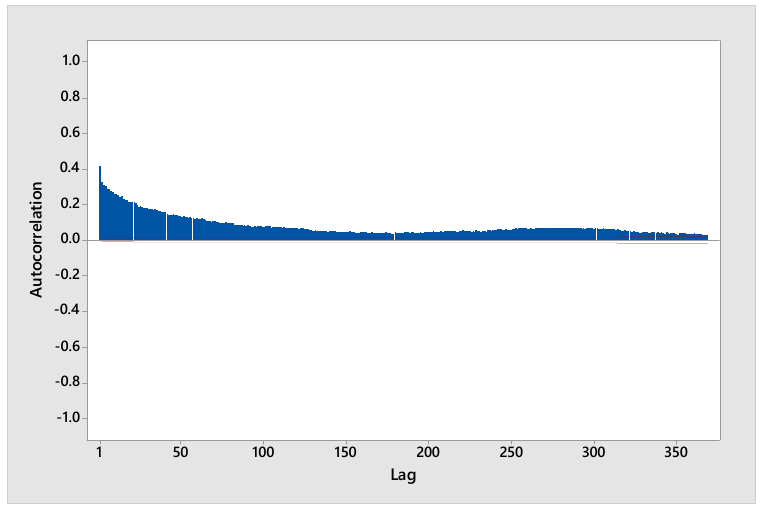
Figure 1. The sample autocorrelation function for the error squared for the wind